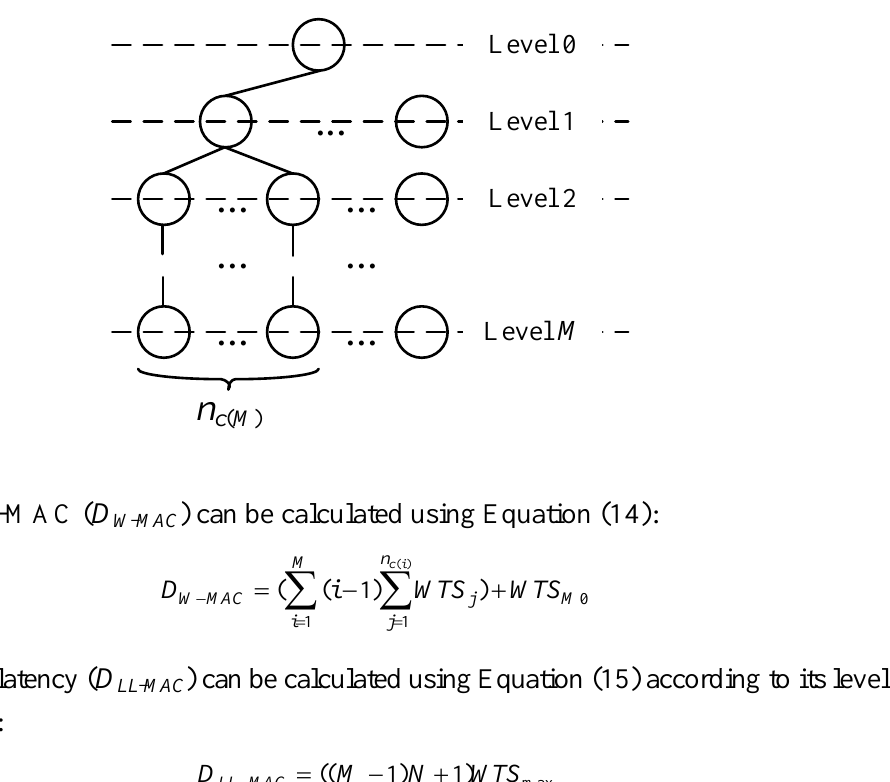
Figure 7. General data collection